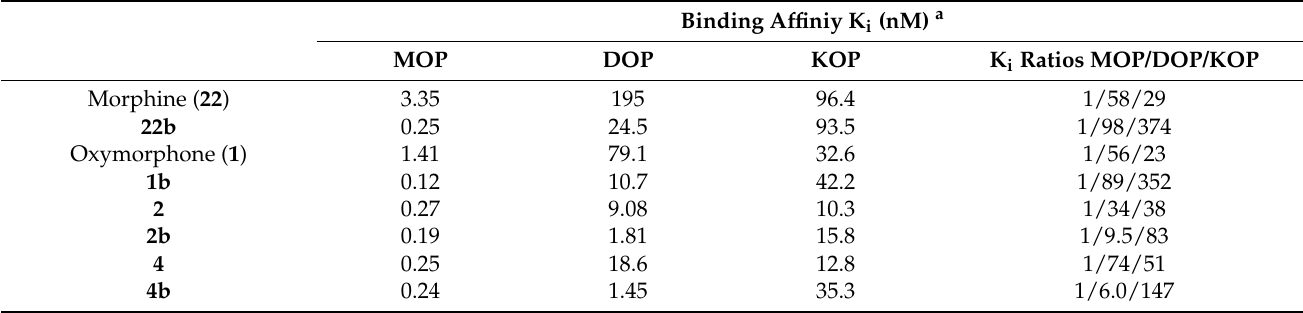
Table 8. Binding affinities at the opioid receptors of N -methylmorphinans 22 , 1 , 2 and 4 , and their N -phenethyl substituted analogues 22b , 1b , 2b and 4b .